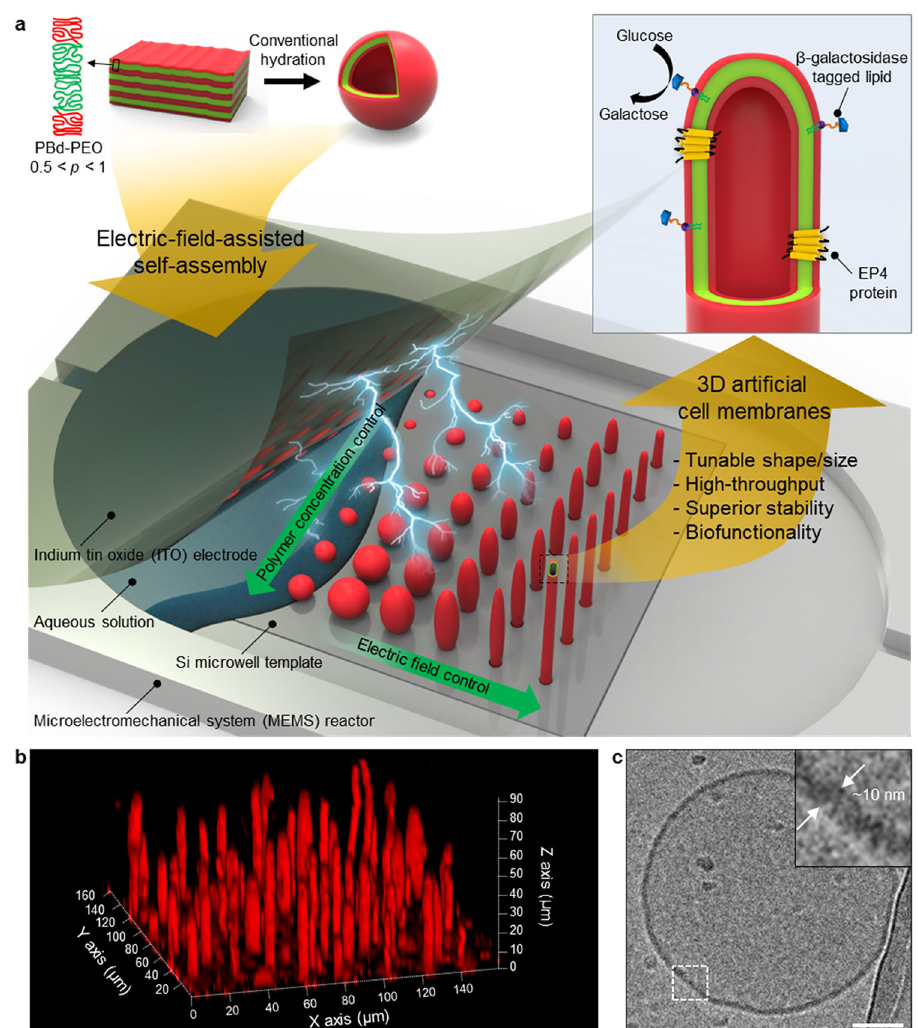
Fig. 1 3D block copolymer arti fi cial cell membranes (3DBCPMs) for versatile biological applications. a Electric- fi eld-assisted self-assembly method for the scalable fabrication of 3DBCPMs with diverse shapes/sizes, high stability, and biofunctionality on silicon (Si) microwell template using a diblock copolymer, namely polybutadiene- b -polyethyleneoxide (PBd-PEO), as a building block and representative biological applications such as protein – membrane assay using prostaglandin E2 receptor 4 (EP4) and arti fi cial intestinal organ using β -galactosidase tagged lipid. The packing parameter, p , is an inherent value of polymers associated with the volume and length of the hydrophobic domain and the optimal area of the hydrophilic domain. b A fl uorescence microscopy image of a cilia-like long 3DBCPM array produced from a patterned template. c A cross-sectional transmission electron microscopy (TEM) image of a unilamellar 3DBCPM composed of ~10-nm-thick bilayer membrane. Scale bar: 100